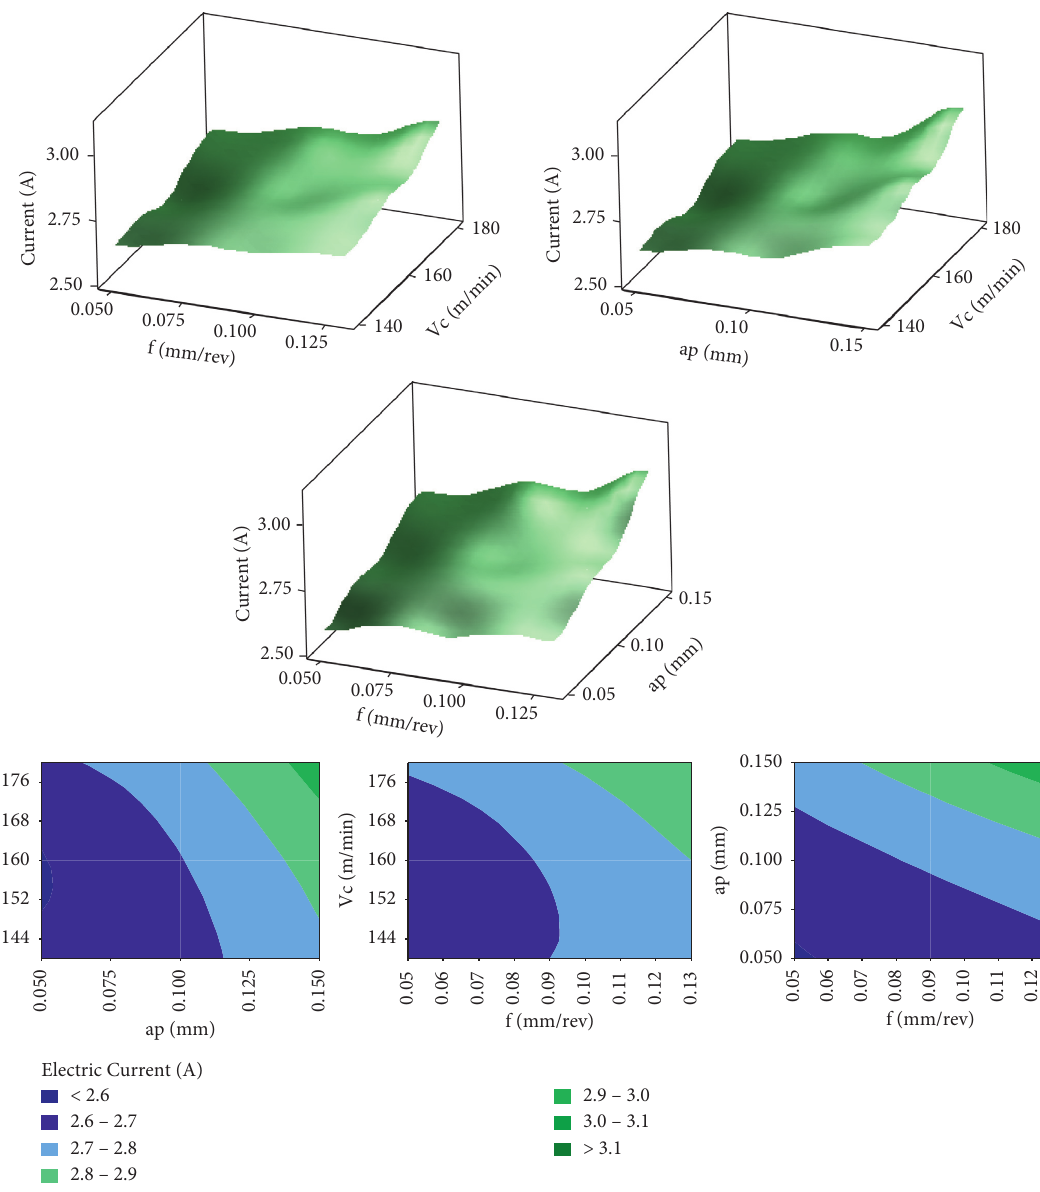
Figure 6: 3D surface plots and contour plots based on cutting parameters for electric current